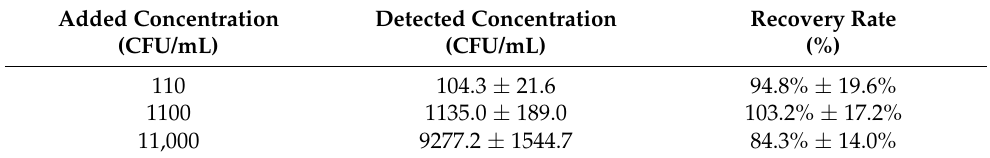
Table 2. The recovery of the spiked Salmonella typhimurium .